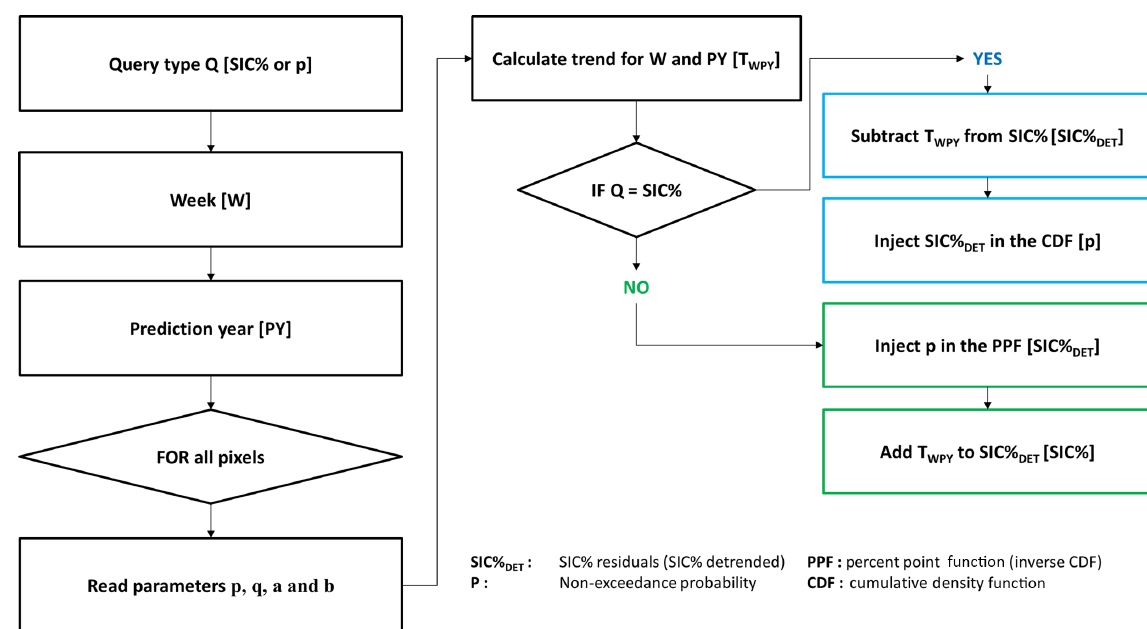
Figure 5. IcePAC query flow chart.